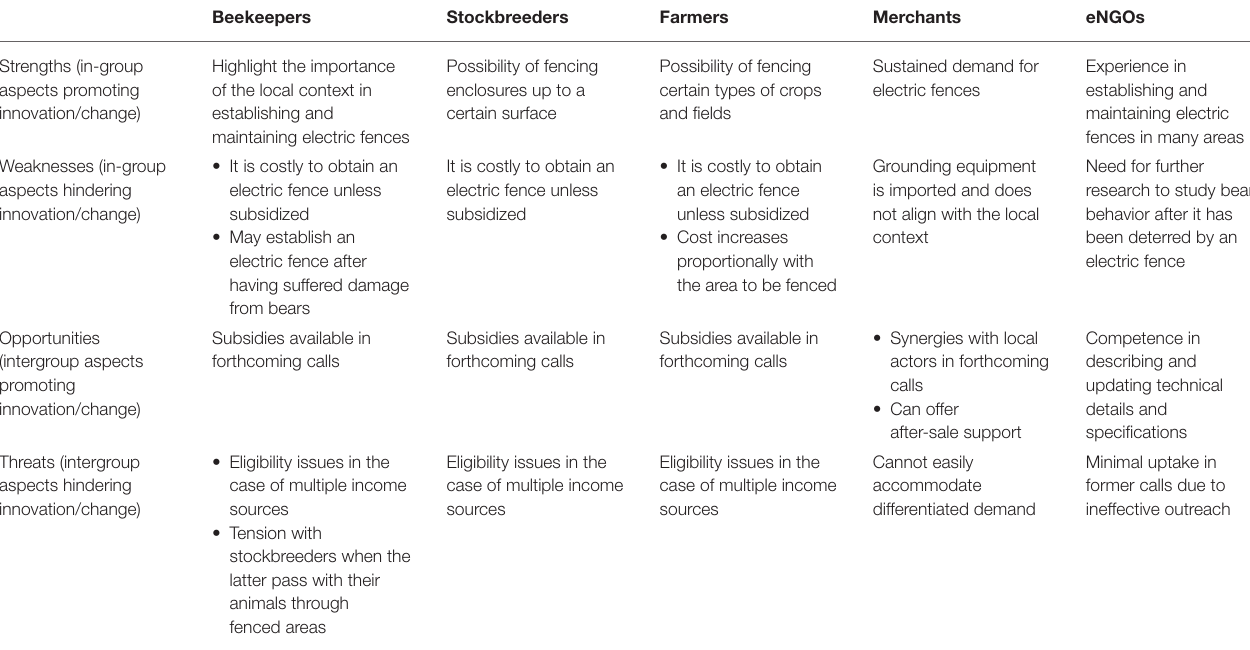
TABLE 4 | SWOT analysis template for electric